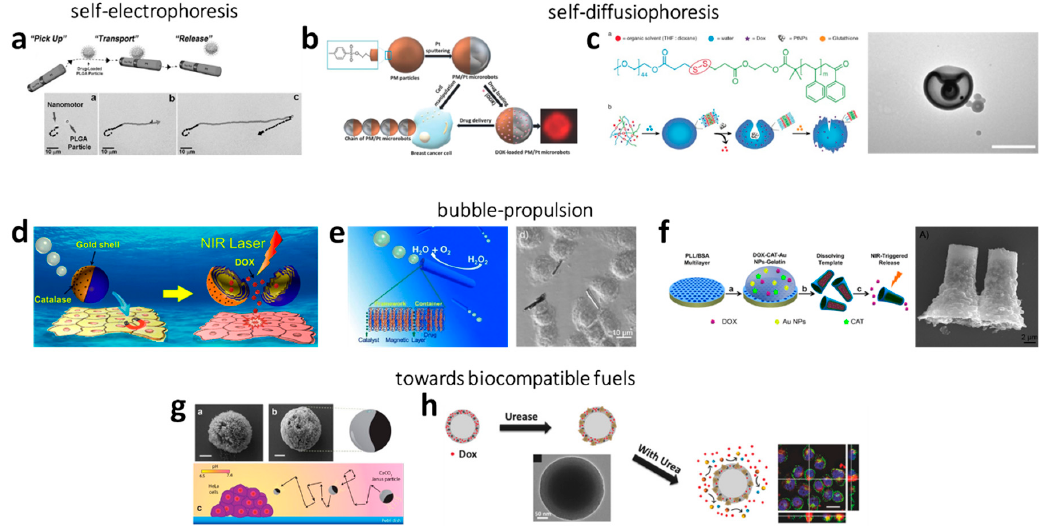
Figure 1. Summarizes selected examples of chemically driven nano- and micromotors: ( a ) Self-electrophoretic propelled Ni / (Au 50 / Ag 50 ) / Ni / Pt nanowires picking-up and transporting polymer particles or liposomes loaded with DOX. Reprinted with permission of John Wiley and Sons, Kagan et al. [57], Copyright 2010. Self-diffusiophoresis in H 2 O 2 of ( b ) DOX-loaded polymer/platinum microparticles, which could be magnetically guided towards breast cancer cells. Reprinted with permission of John Wiley and Son, Villa et al. [62], Copyright 2018. and ( c ) polymers in stomatocyte morphology loaded with platinum as catalyst and DOX as anticancer drug. The TEM images shows the stomatocytes, scale bar is 200 nm. Reprinted with permission from Tu et al. [61],